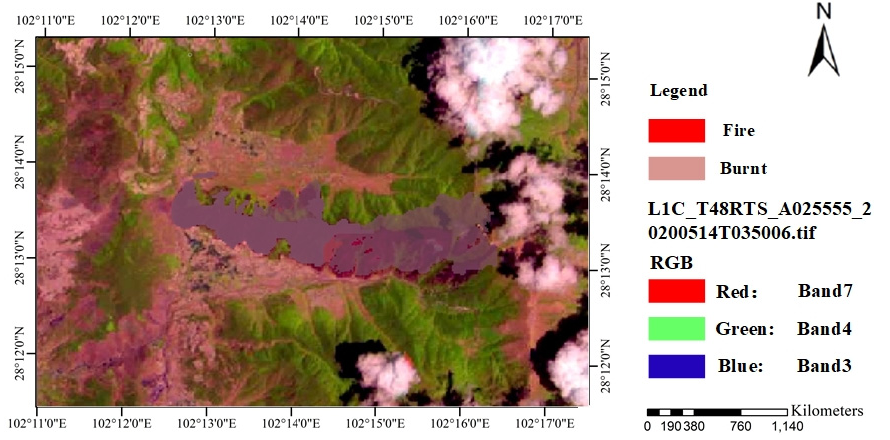
Figure 6. Simulation result graph.